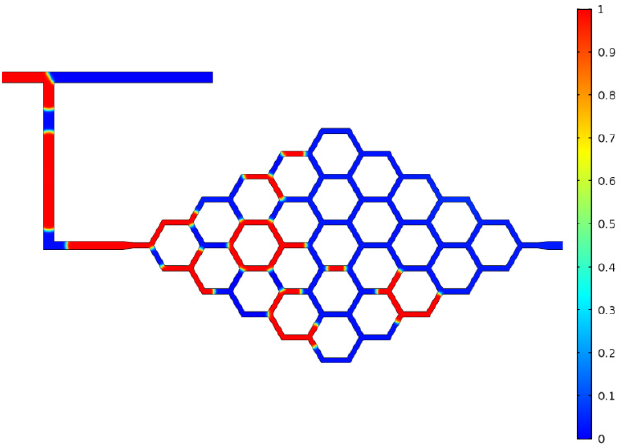
Figure 4. The curve of velocity versus position from the tip to the rear of the liquid column.